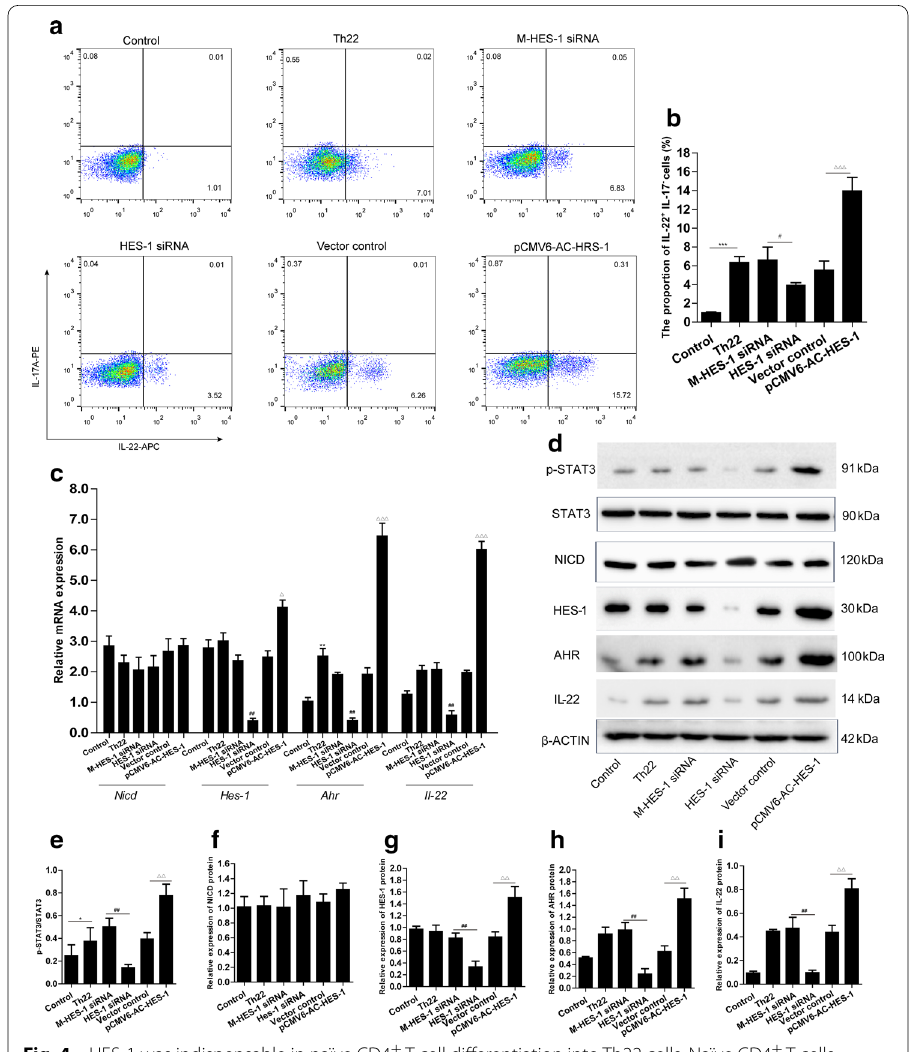
Fig. 4 HES-1 was indispensable in naïve CD4 + T cell differentiation into Th22 cells. Naïve CD4 + T cells were transfected with HES-1-siRNA, HES-1 plasmid, or their controls. Subsequently, the transfection cells were cultured in conditions designed to induce Th22 differentiation. a The intracellular IL-17A and IL-22 in transfection CD4 + T cells were assayed by flow cytometry 6 days after the combination of factors induced Th22 cells. b Quantitative analysis of the percentage of IL-22 + IL-17A − cells was performed. c RT-PCR was performed to evaluate the expression of Nicd , Hes-1 , Ahr , and Il-22. d Western blot for p-STAT3, STAT3, NICD, Hes-1, AHR, and IL-22 was performed to assess the alteration. e i The relatively quantified protein − bands from western blot were executed with the Quantity One software and data were represented as the means S.E.M. of three different experiments. * p < 0.05, *** p < 0.001, compared with the control group; ± # p < 0.5, ## p < 0.01, for HES-1 siRNA versus M-HES-1siRNA groups; △ p < 0.05, △△ p < 0.01, △△△ p < 0.001, for pCMV6-AC-HES-1 versus vector control